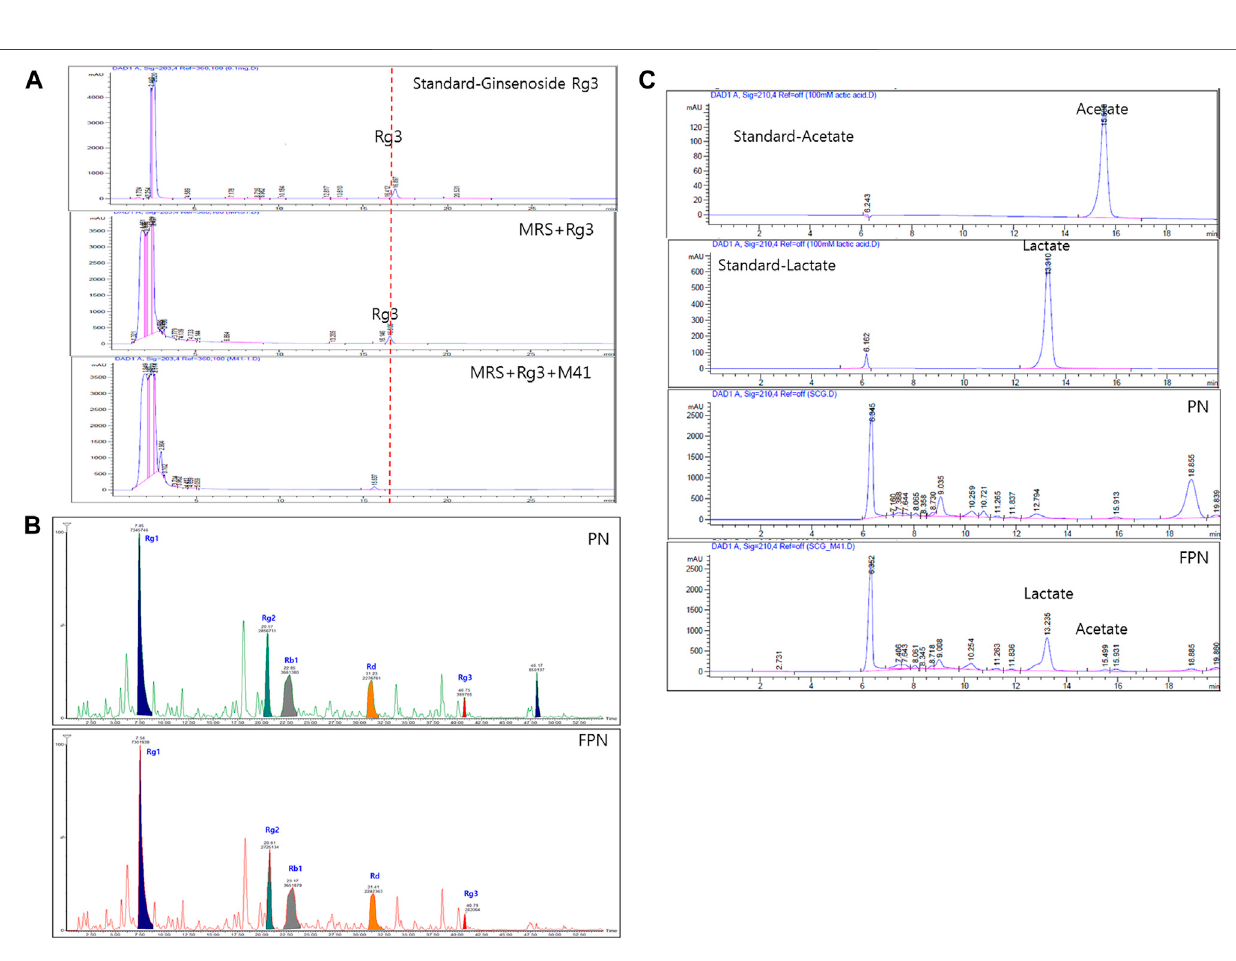
Frontiers in Pharmacology |